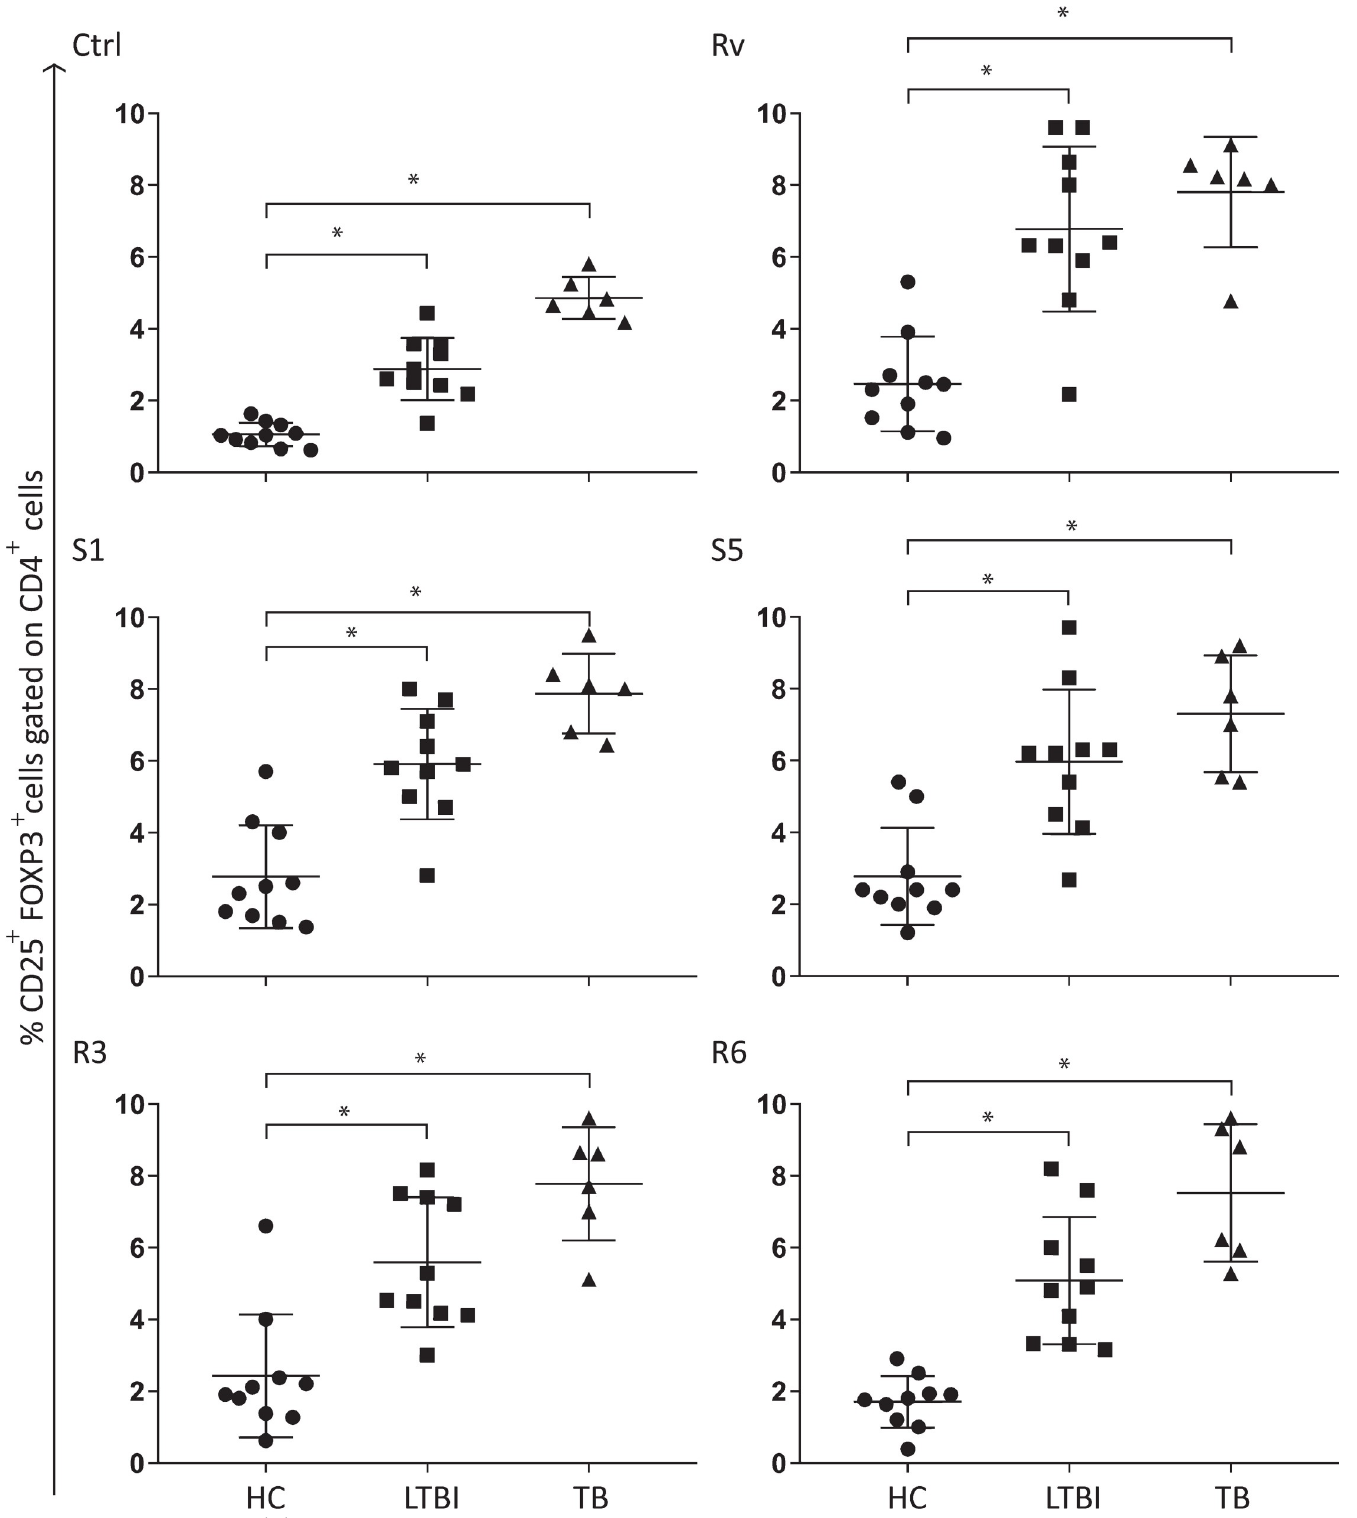
Fig 2. Frequency of CD4 + CD25 high FoxP3 + cells is increased in peripheral blood of LTBI and active TB patients. Peripheral blood from healthy control subjects (HC, n = 10), latent infected individuals (LTBI, n = 10), and active pulmonary TB patients (TB, n = 6) were cultivated in the presence or absence of live Mtb by 72